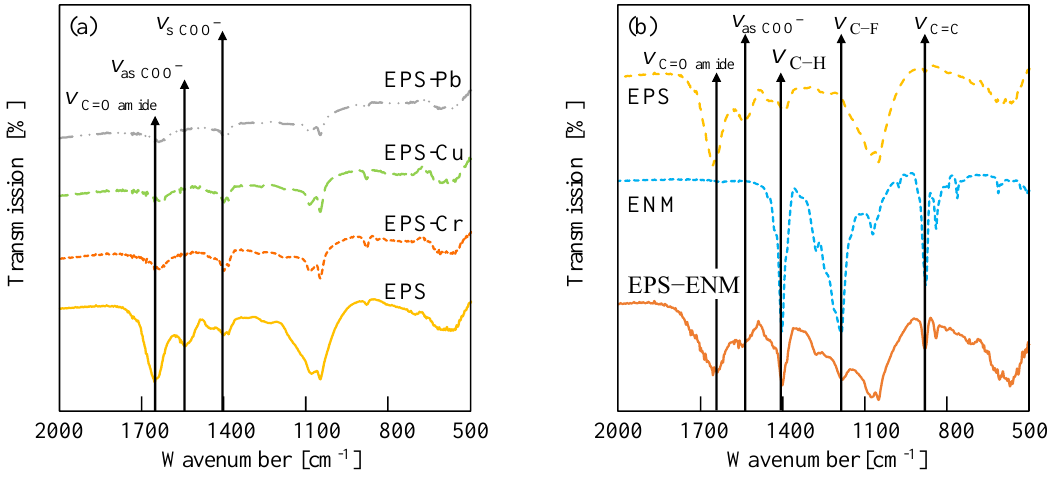
Figure 11. FTIR spectra for the various samples: ( a ) the EPS filter cake before and after the adsorption of HIMs to give EPS-Pb, EPS-Cu, and EPS-Cr; ( b ) the EPS, ENM, and EPS – ENM samples.